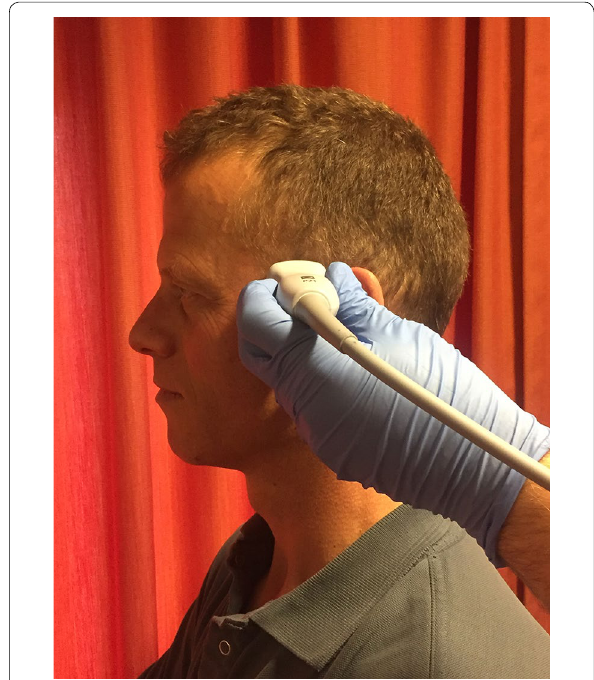
Fig. 9 Ultrasound transducer positioned at the temporal window. The ultrasound transducer is positioned at the site where the temporal bone is thinnest and the ultrasound beam is least obstructed penetrating the skull (Reproduced with permission from Rob Stoffels and Yvonne